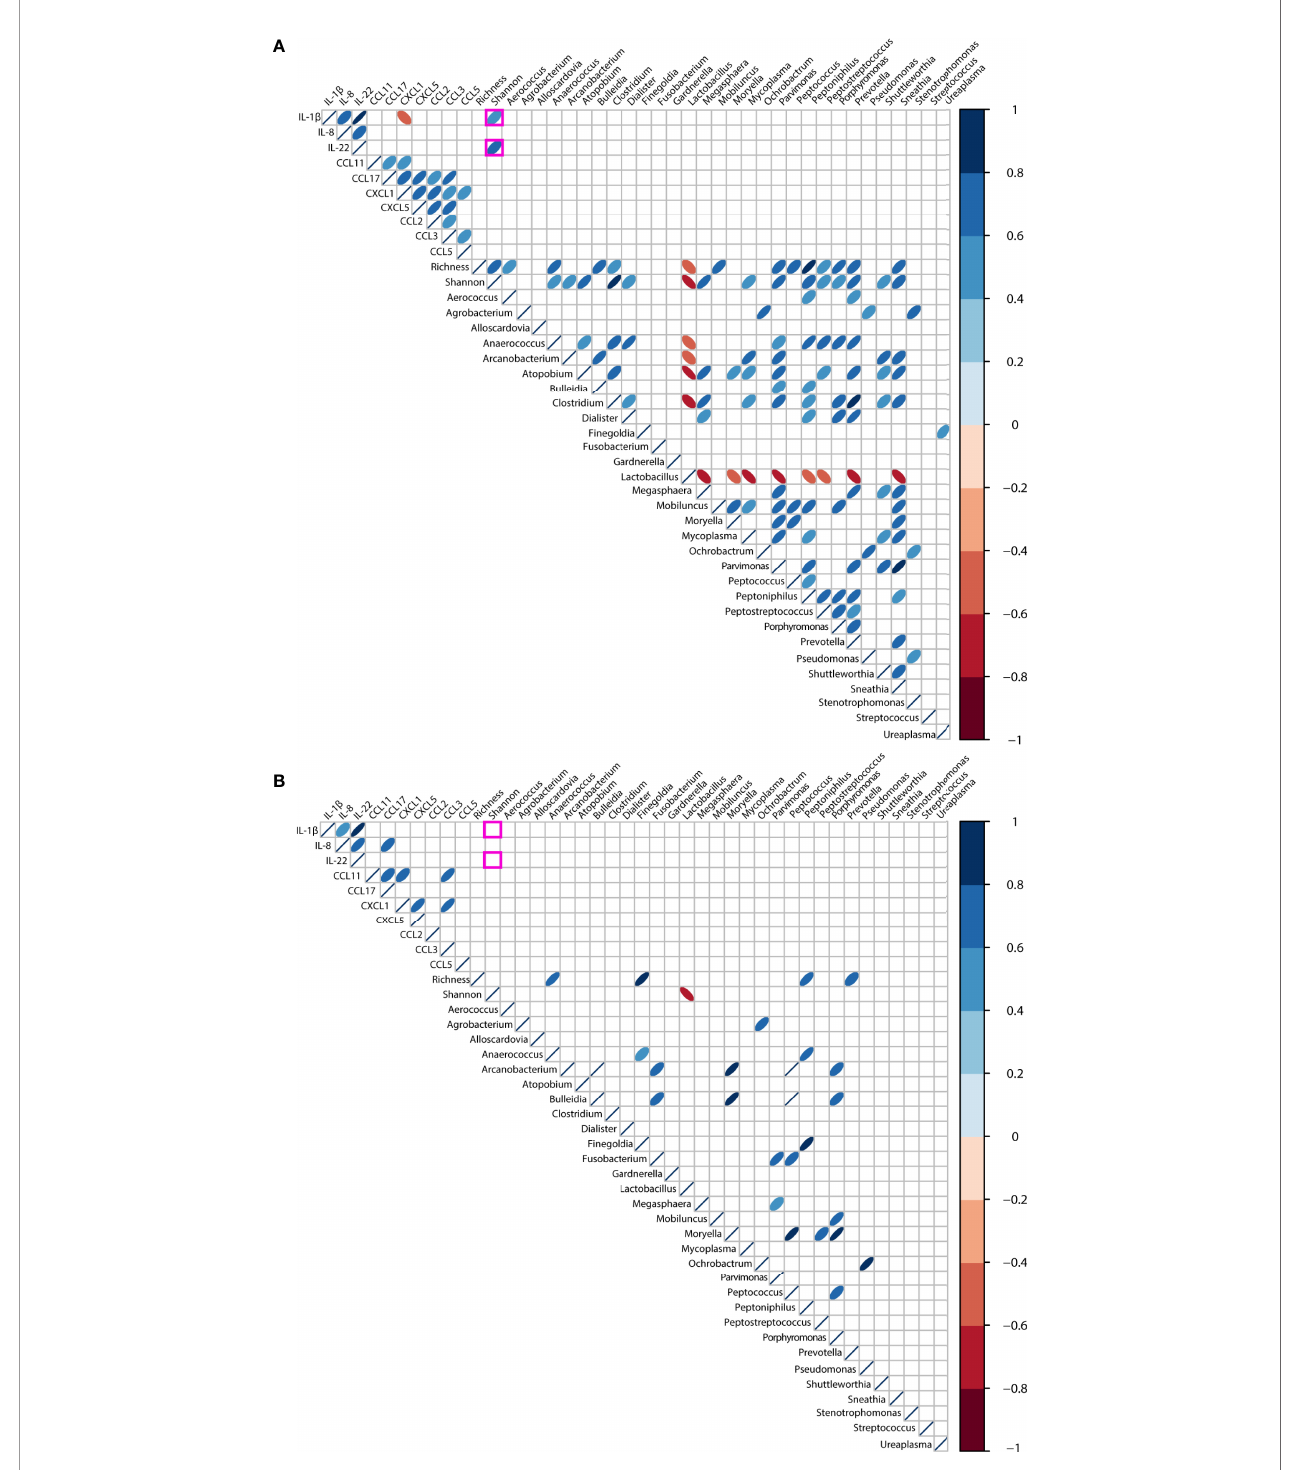
FIGURE 5 | Correlations between the vaginal microbiota and genital in fl ammation in women with symptomatic cervical ectopy with (A) or without (B) HPV infection. Correlations were computed using Spearman test, and visualized using corrplot. Only p values< 0.01 are shown. Positive rho values are shown in blue, negative rho values shown in red, the intensity of the color is proportional to the strength of the rho